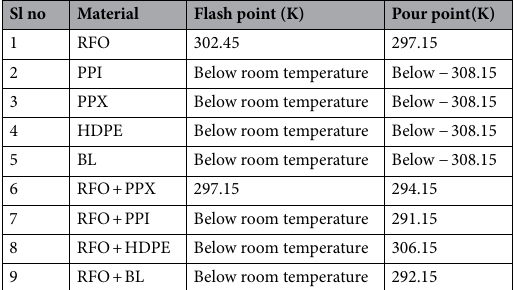
Table 8. Flash Point and Pour Point of the liquid product derived from the co-cracking of RFO with various types of waste plastics (PPI, PPX, HDPE, and BL).